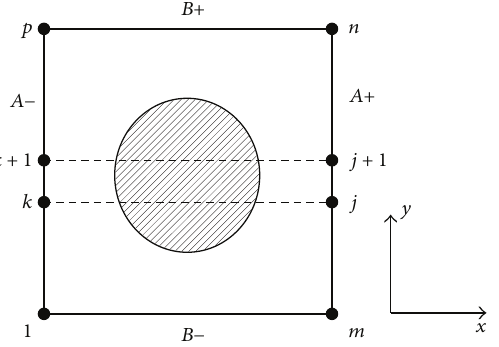
Figure 3: Application of periodic boundary conditions from a coordinate’s view.